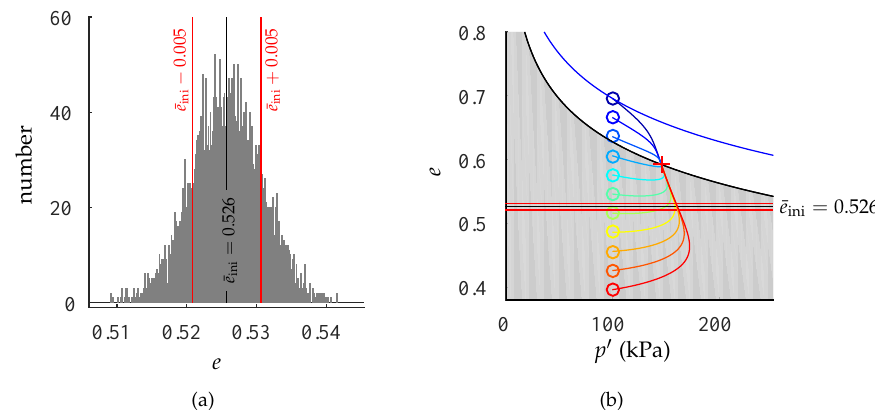
Figure 5. For OCR = 6 follows the mean value ¯ e ini = 0.526, black line. The standard deviation is 0.005. The red lines mark the standard deviation, i.e., ¯ e ini distributed over all 5000 elements. ( b ) shows the range in the e - p (cid:48) plot with ¯ e ini and ¯ e ini